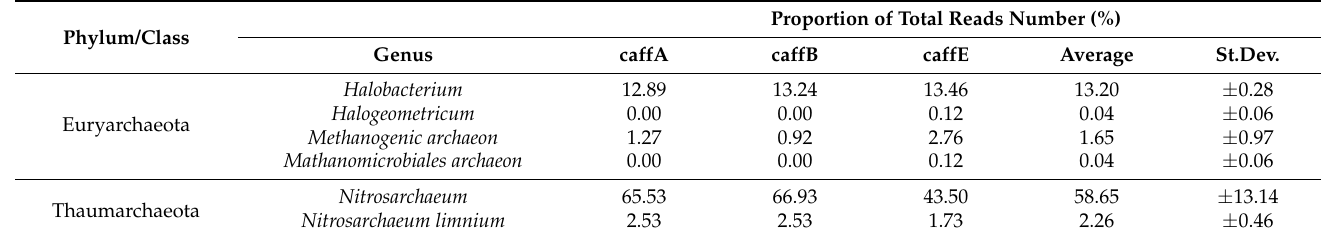
Table 4. Genera retrieved within the archaeal